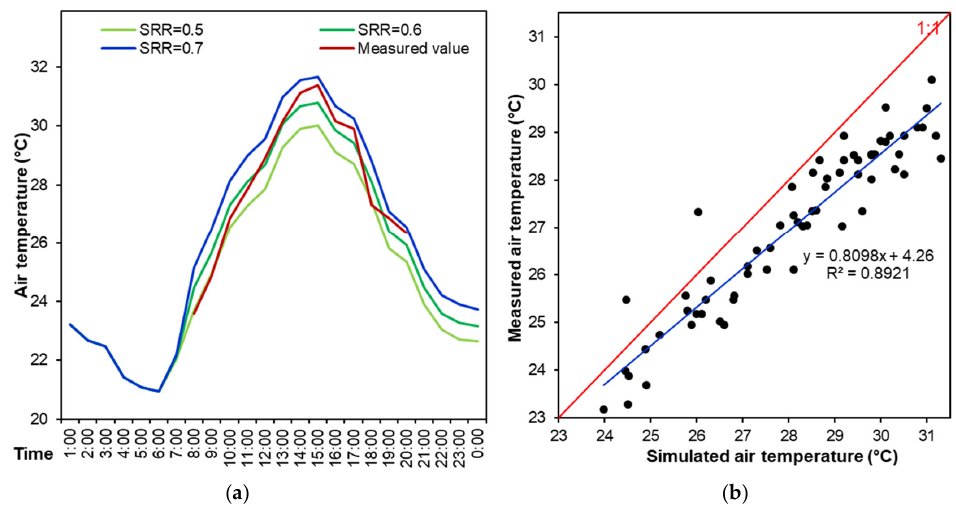
Figure 7. Calibration of ENVI‐met model. ( a ) Comparison of measured average air temperature of five points with numerical results in different scenarios of solar radiation, and ( b ) Correlations between measured and simulated air temperatures of five points (from 08:00 to 20:00 h).